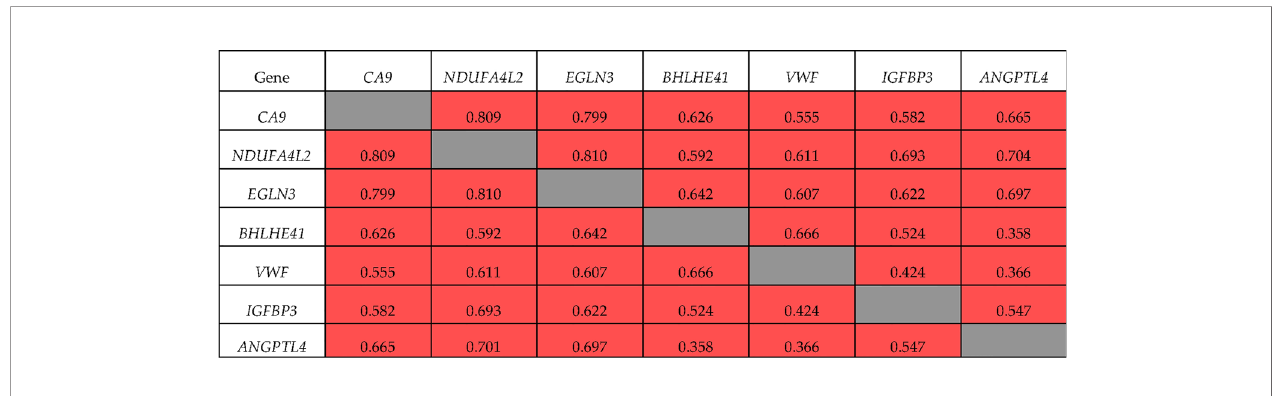
FIGURE 2 | Correlation of gene expression during tumor progression. ■ signi fi cant